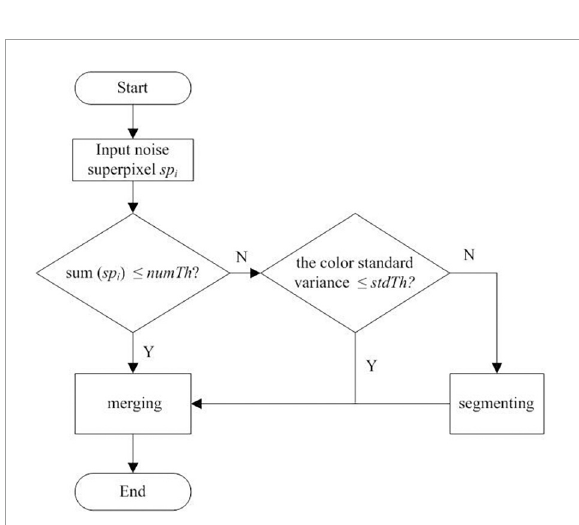
FIGURE2 Workflow to deal with the small and large noise superpixels of the initial clustering